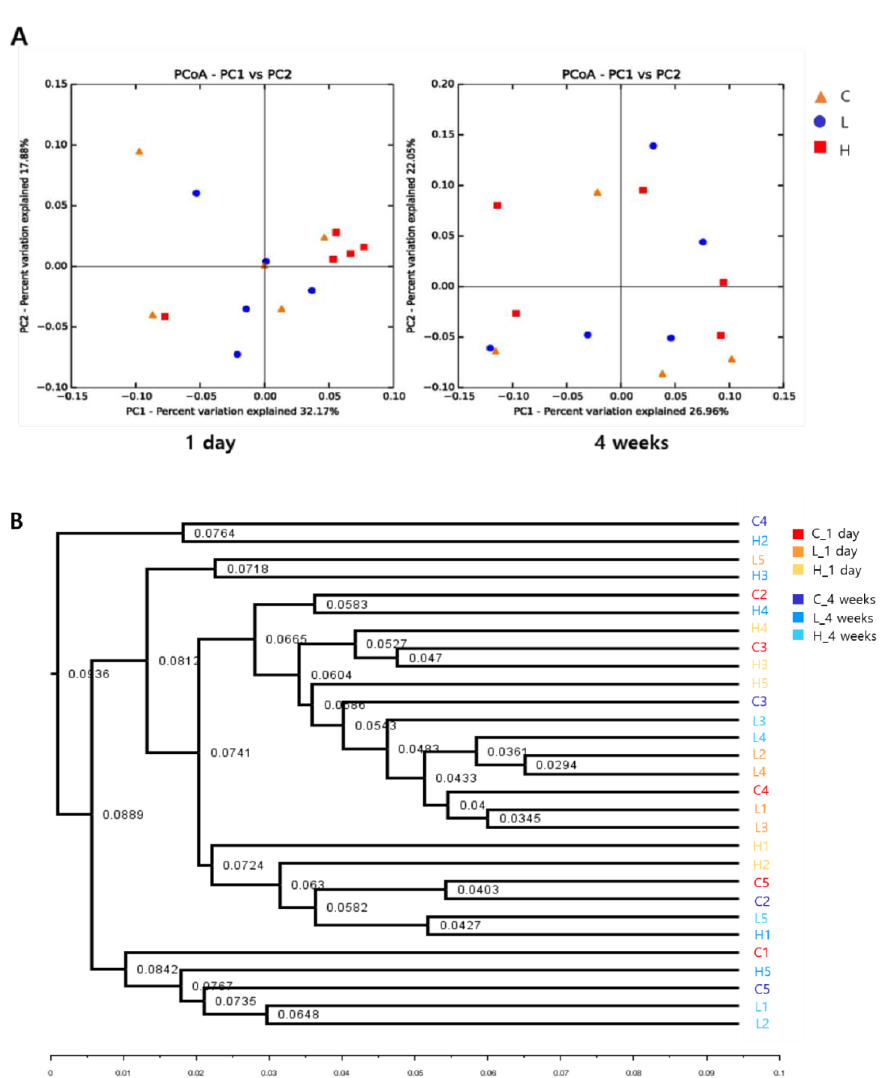
Figure 6. Beta diversity of principal coordinates analysis (PCoA) of weighted unifrac distances ( A ). Unweighted pair group method with arithmetic mean (UPGMA) cluster analysis based on community composition of each sample in at phylum level ( B ). The similarities of lung microbial composition between instillation groups of NiO NPs and control group were not significant at the phylum level. C: control group; L: low-dose group (50 cm 2 /rat); H: high-dose group (150 cm 2